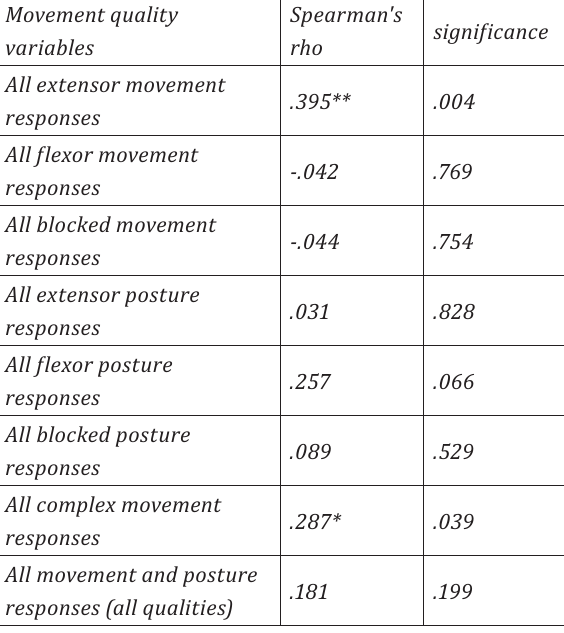
Table 11. The values of Spearman’s rho between the “chiaroscuro” variable and movement quality variables